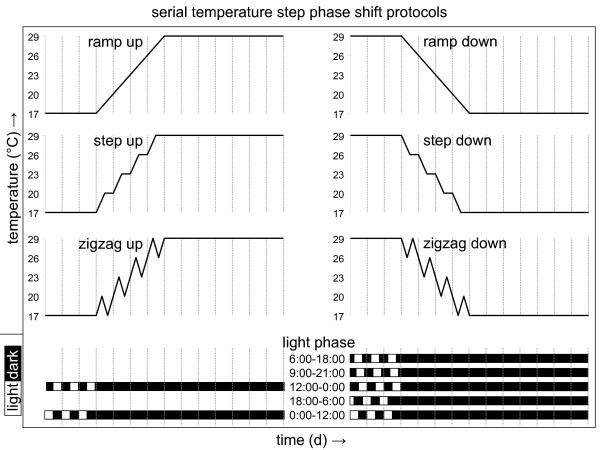
Environmental protocols used to study temperature entrainment in the context of continuous increases or decreases in absolute temperature. Different environmental protocols were used as indicated. First, flies were entrained to three 12-h light/12-h dark cycles at one of several phases as indicated by the white/black bars at the bottom of the panel. Next, they were subjected to a 4-day temperature regimen that superimposed a continuous temperature increase or decrease (3°C per day) on either otherwise constant temperature (ramp up or down) or daily temperature gradients with a range of 1.5°C (step up or down) or 4°C (zigzag up or down) (see Additional file 2). Note that the composite temperature profiles each show a range of 3°C on each consecutive day. Finally, the flies were released into free run at 17°C or 29°C in constant darkness. Each temperature protocol was combined with the light/dark protocols indicated below it, with the exception of 'step down' which was combined with four of the five indicated light/dark profiles (9:00 to 21:00 light phase was not used).